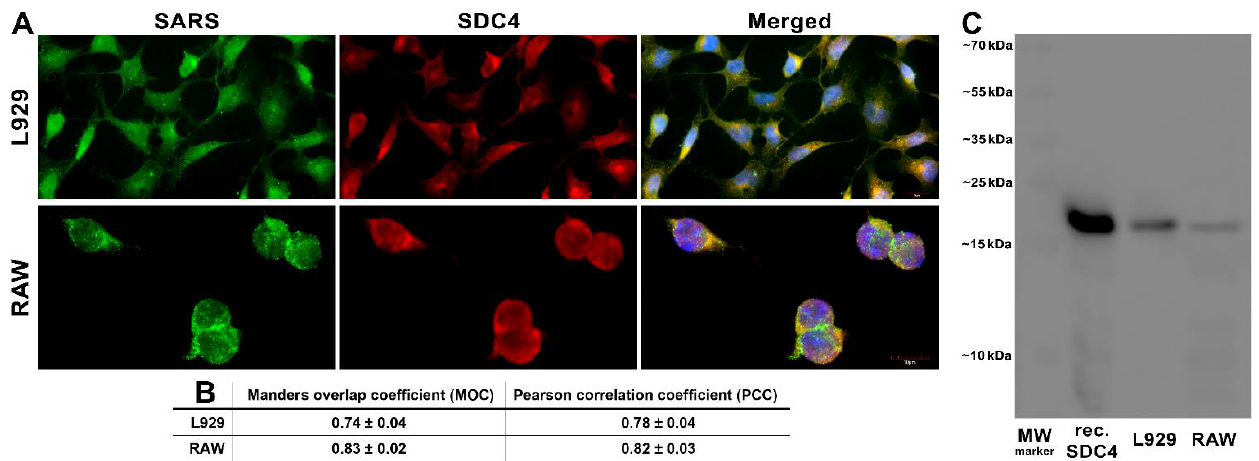
Figure 6. SARS-CoV-2 colocalizes with SDC4 during cellular entry. L929 and RAW cells were incu- bated with heat-inactivated SARS-CoV-2 (at 1 MOI) for 3 h at 37 °C. After incubation, the cells were washed, fixed, permeabilized, and treated with antibodies specific for the spike glycoprotein (AF 488 labeled) and SDC4 (APC labeled). Colocalization of SARS-CoV-2 with SDCs was analyzed with confocal microscopy. ( A ) Microscopic analyses of SARS-CoV-2 and SDC colocalization. Representa- tive images of three independent experiments are shown. Scale bar = 10 μm. ( B ) The MOC and PCC ± SEM for the overlap and colocalization of SDC with SARS-CoV-2 (indicated below the images) were calculated by analyzing 18 images with an average of 12 cells in each image (from 3 separate samples). Scale bar = 10 μm. ( C ) A representative Western blot showing SDC4 immunoprecipitated with SARS-CoV-2 in L929 and RAW cells. Lane 1: 0.5 µg of SDC4; lanes 2 – 3: immunoprecipitates of